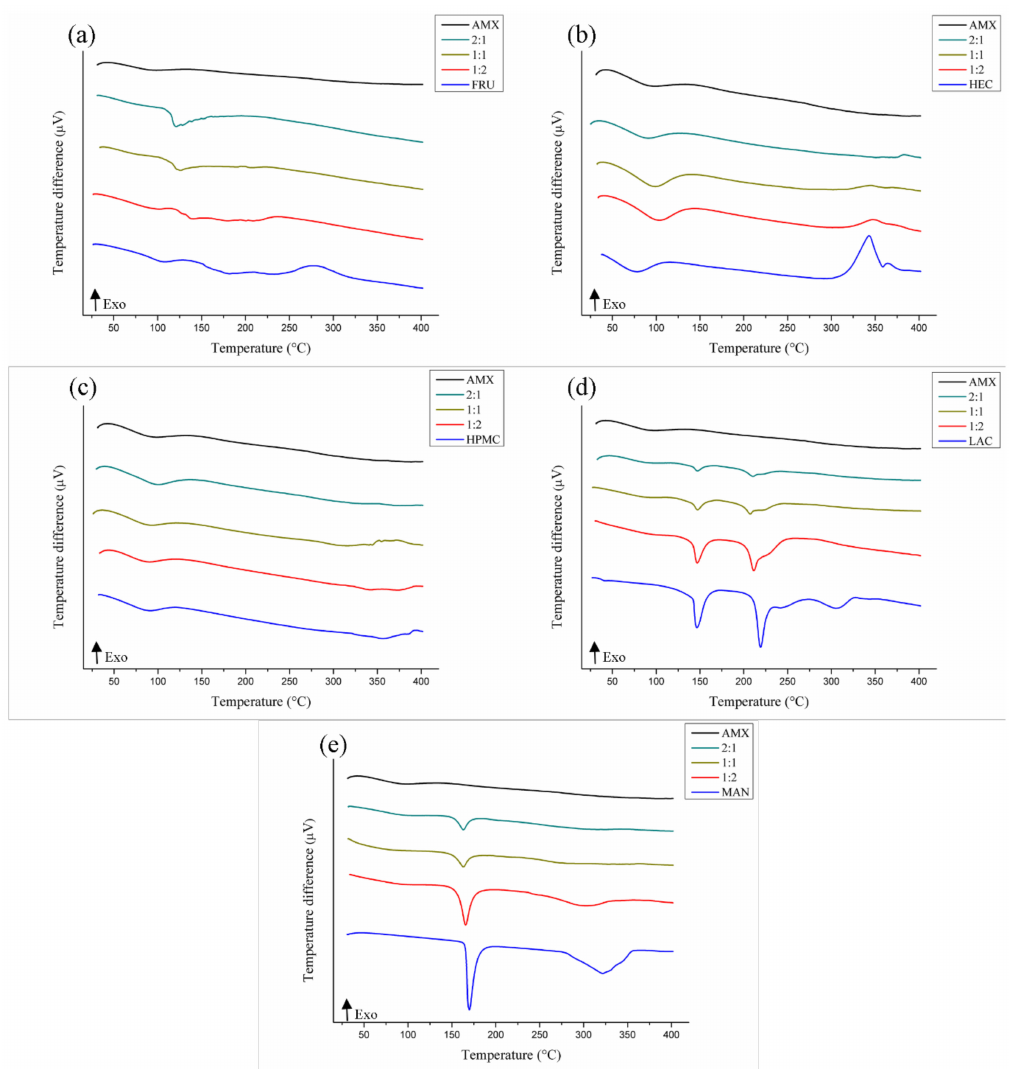
Figure 3. DTA curves of binary mixtures of AMX and pharmaceutical excipients: fructose ( a ), hydroxyethylcellulose ( b ), hydroxypropyl methylcellulose ( c ), lactose ( d ), and mannitol ( e